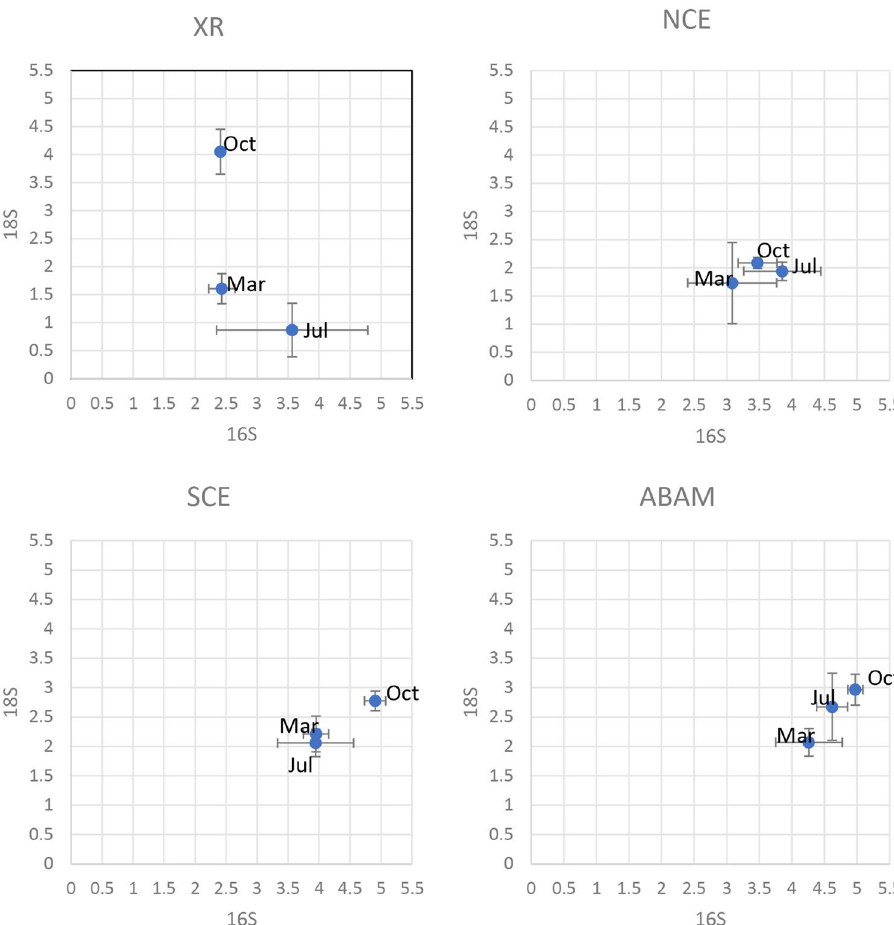
Figure 6. Pearson plots of microbial Shannon index against macrobenthic Shannon index over three